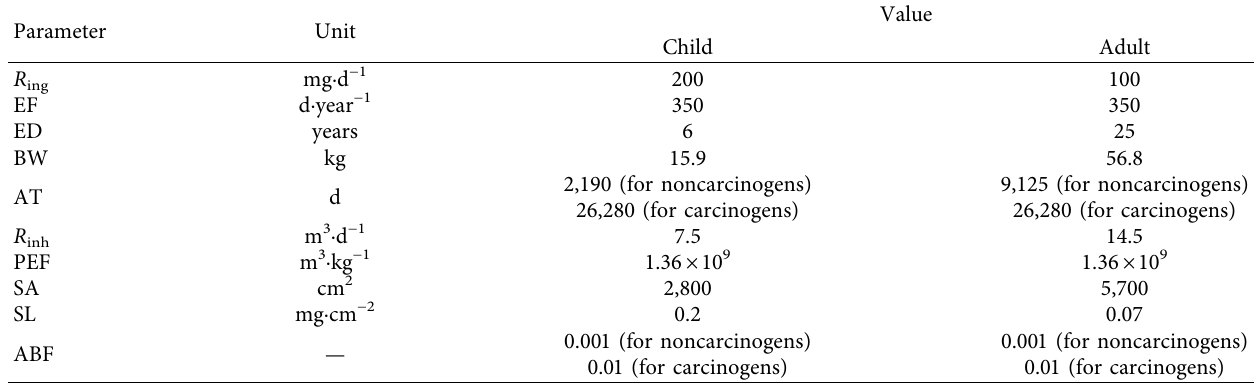
Table 3: Exposure parameters for the health risk assessment models.